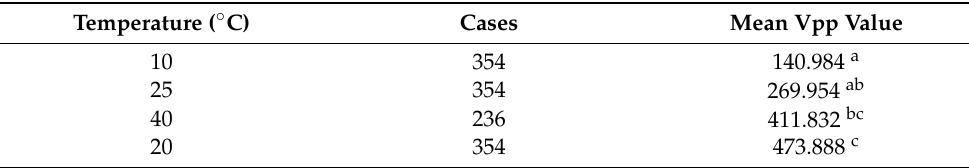
Table 7. Duncan’s Multiple Range Test for Temperature of Two-Way ANOVA results for the delay with all gathered data.